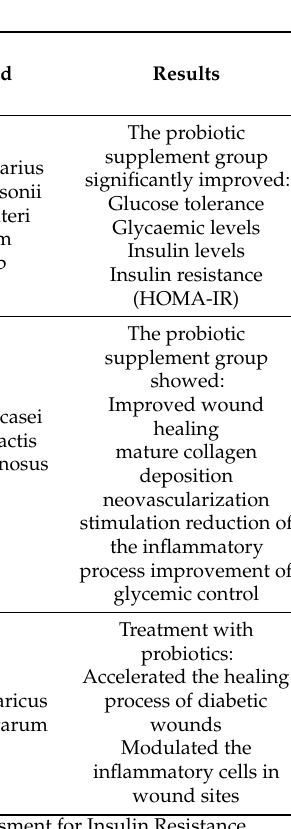
Table 4. Probiotic supplements and in-vivo models of DM